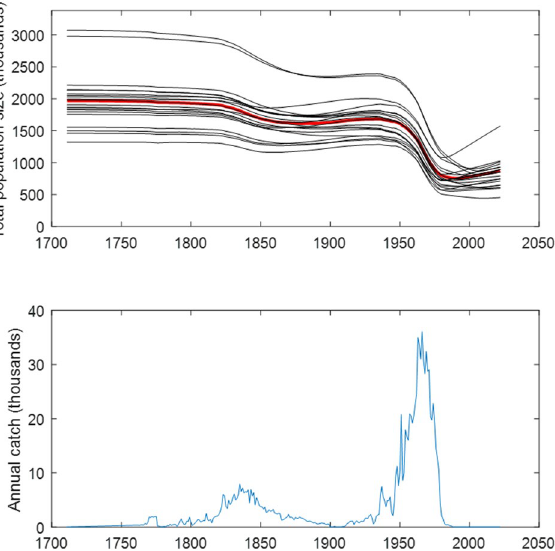
Figure 4. Upper: Estimated trajectories of global sperm whale population using best estimates for model parameters in red, and 20 trajectories using randomly chosen but reasonable parameter estimates in black. Lower: Reported annual global sperm whale